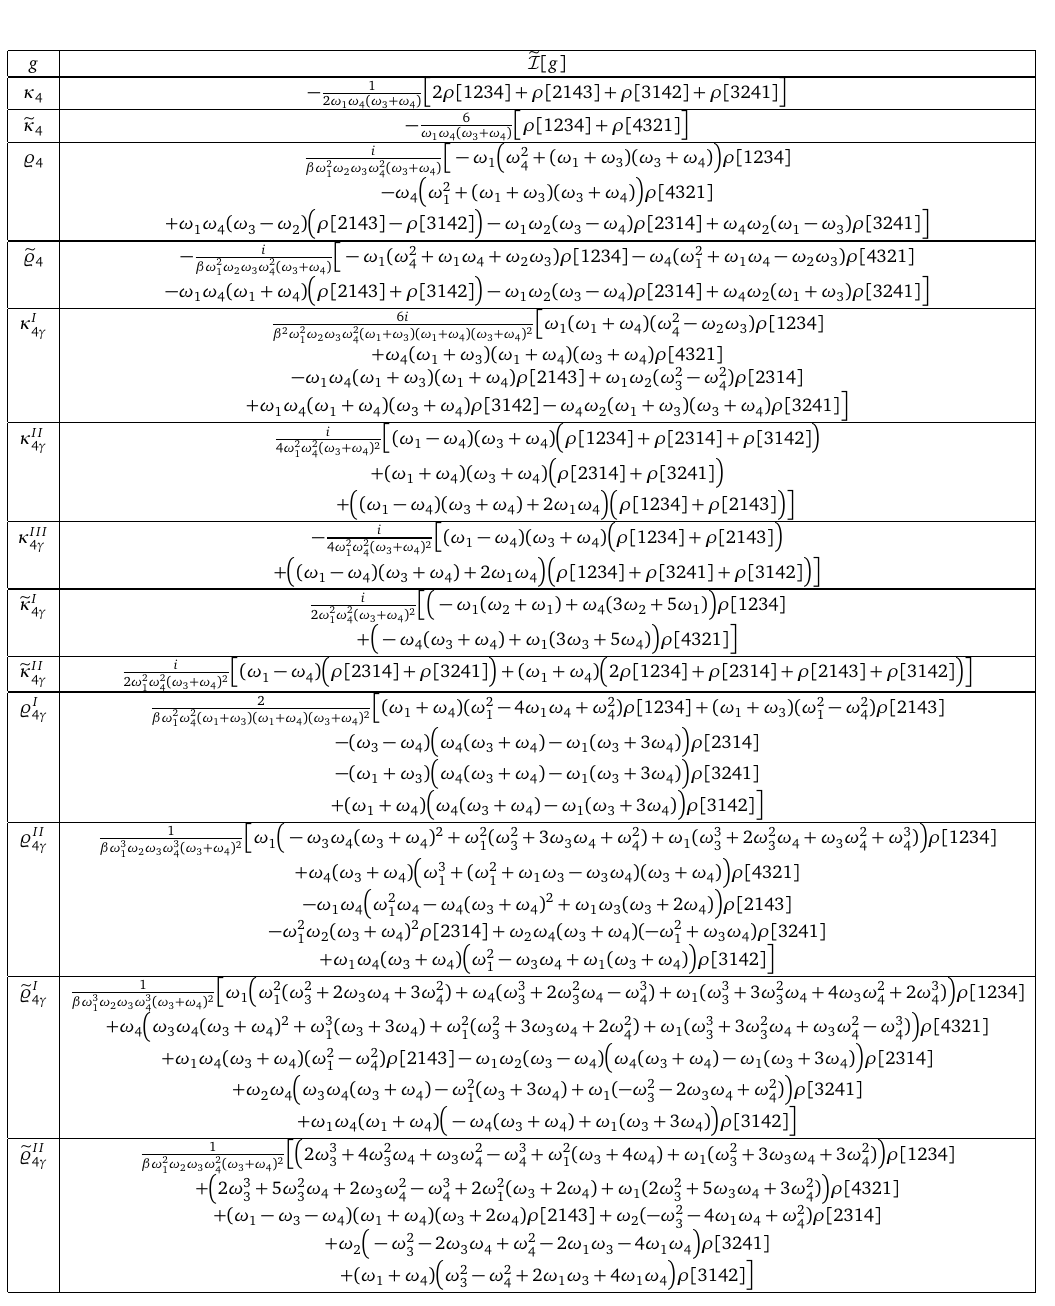
Table 8: OTO couplings upto leading order in